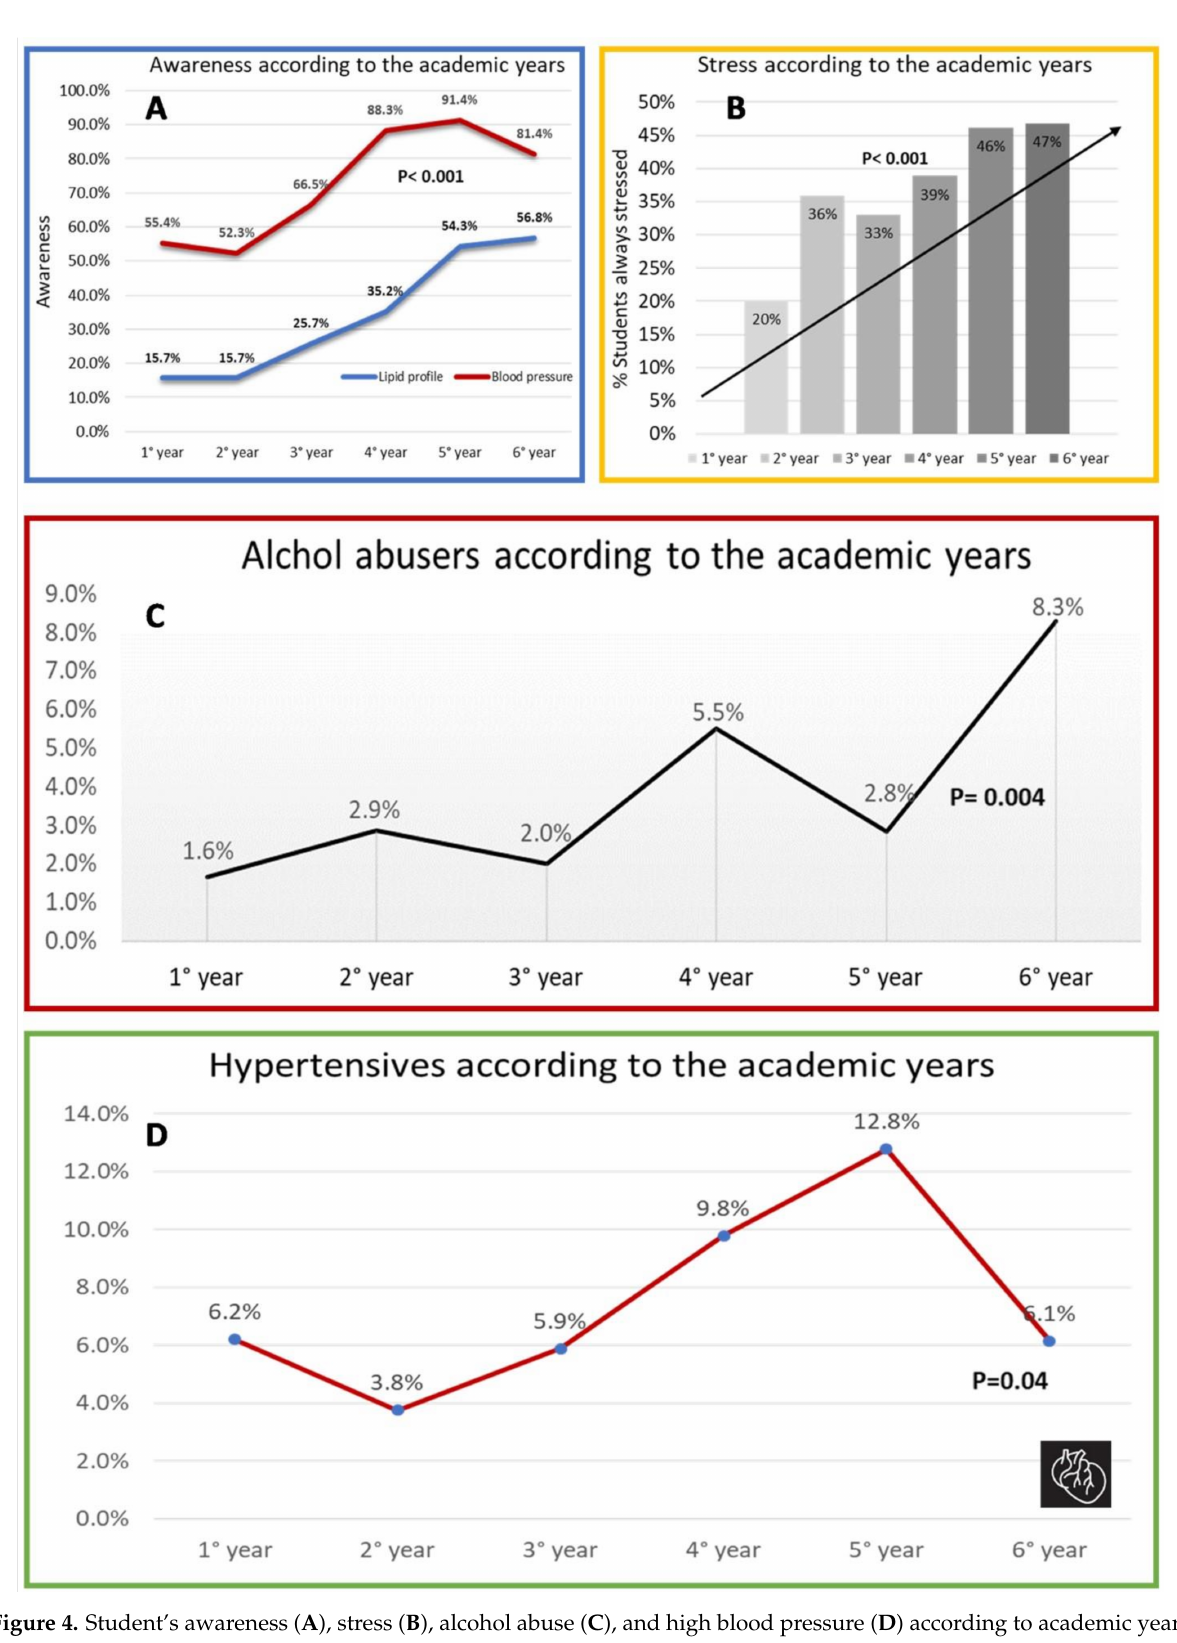
Figure 4. Student’s awareness ( A ), stress ( B ), alcohol abuse ( C ), and high blood pressure ( D ) according to academic years. ( A ) Blood pressure and lipid profile awareness increase with the academic course years. ( B ) University-related stress progressively rises over the course of academic years. ( C ) Alcohol abusers (>10 (female)/>15 (male) alcoholic units per week) according to the course years. ( D ) Number of hypertensive students grows over the years of the